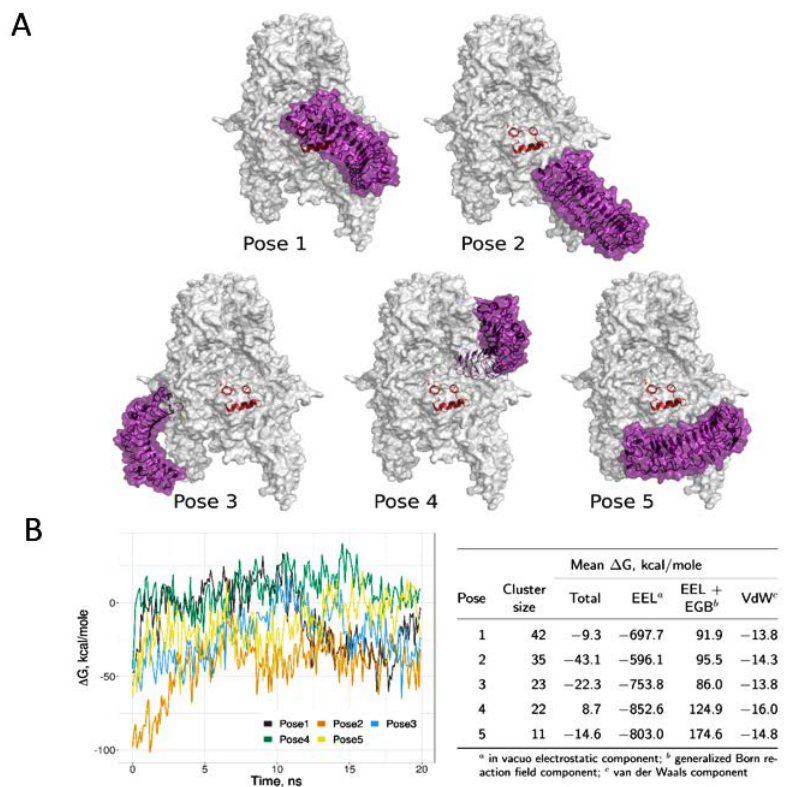
Figure 4. IGF-IR/biglycan possible binding sites. ( A ) The five binding poses of apo-IGF-IR (white) and human biglycan (purple) were obtained from ClusPro. IGF-I is shown in red cartoon to indicate its binding site within the receptor. The receptor structure used in docking was not complexed with IGF-I. ( B ) Total binding free energy ( ∆ G) obtained from MM-GBSA calculations from the 20 ns MD simulation is plotted for all five poses. The table lists the mean decomposed free energy components and the cluster sizes corresponding to each analyzed binding